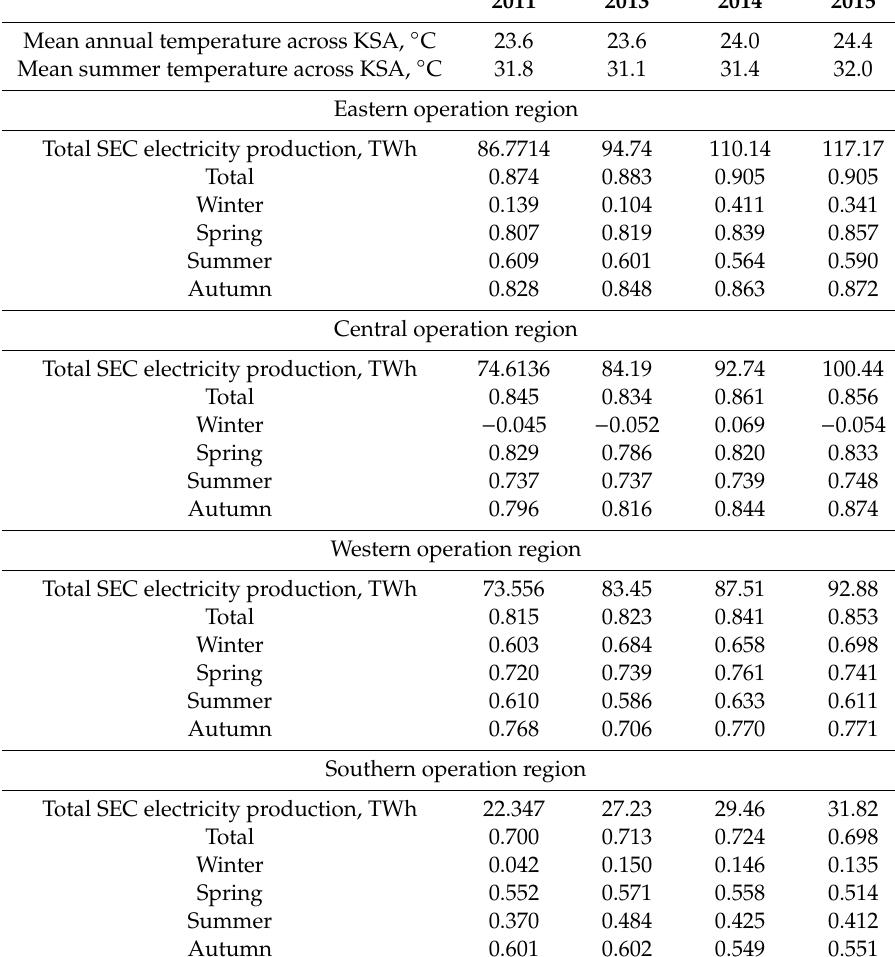
Table A1. Hourly temperature-power correlation coe ffi cients.